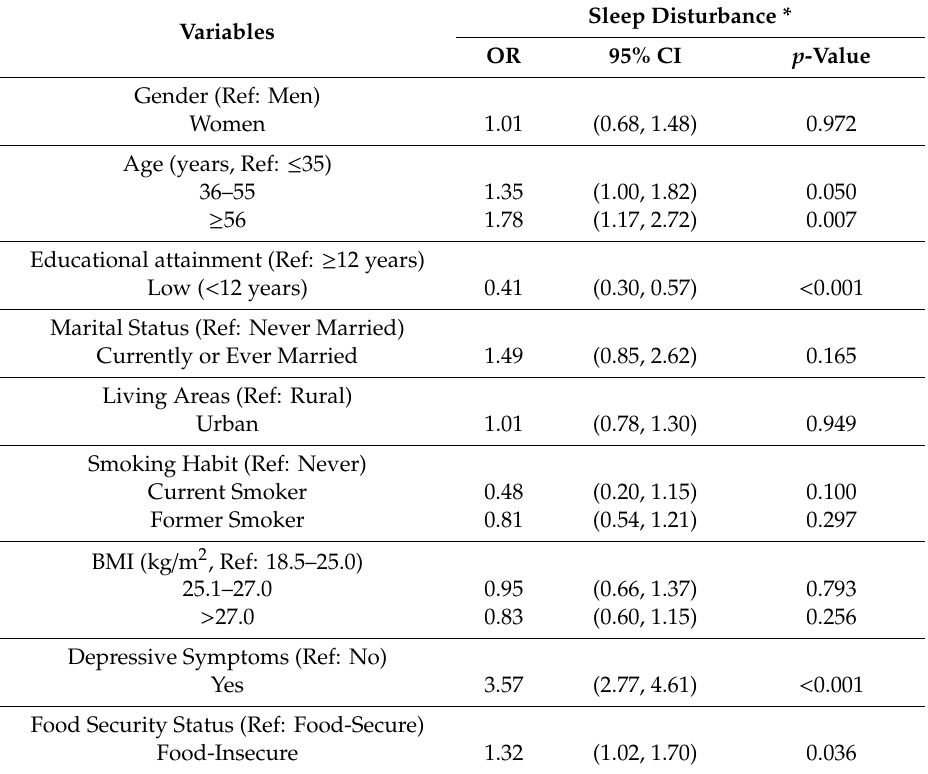
Table 2. Characteristics related to the sleep disturbance level, as determined by the regression